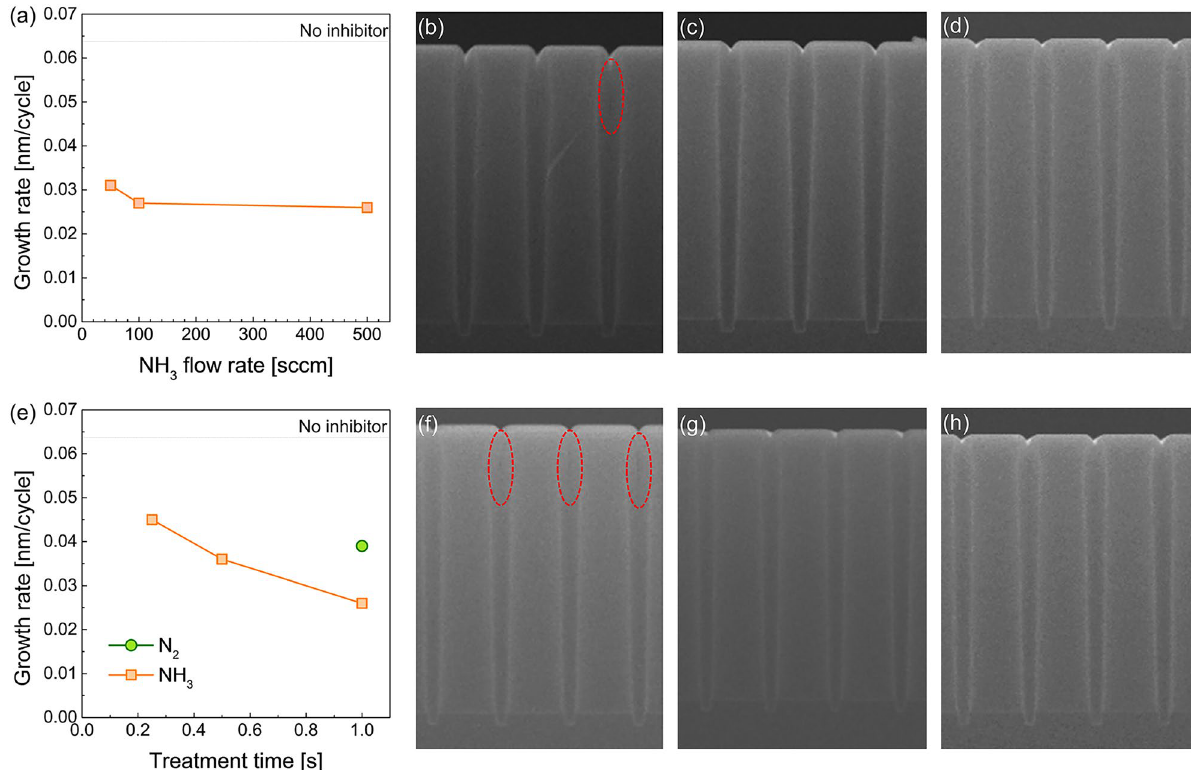
Figure 7. ( a ) GPC of SiO 2 PE-ALD using NH 3 * with various NH 3 flow rates. Cross-sectional FE-SEM images of the trench pattern after deposition of SiO 2 thin film using NH 3 * with NH 3 flow rate of ( b ) 50, ( c ) 100, and ( d ) 500 sccm. ( e ) GPC of SiO 2 PE-ALD using NH 3 * with various treatment times. N 2 * with treatment time of 1 s is represented by the green dot for comparison. Cross-sectional FE-SEM images of the trench pattern after deposition of SiO 2 thin film using NH 3 * with treatment time of ( f ) 0.25, ( g ) 0.5, and ( h ) 1.0